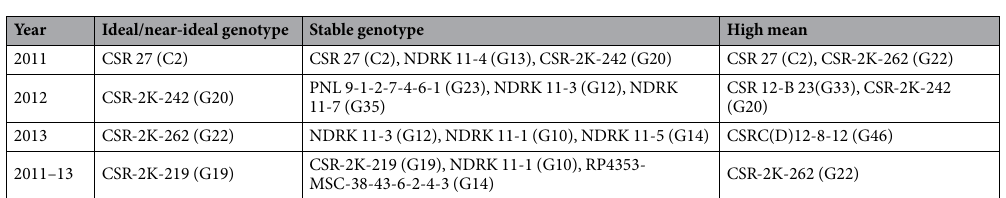
Table 4. Summary of ideal genotypes and genotypes with stable and high mean yields in different seasons